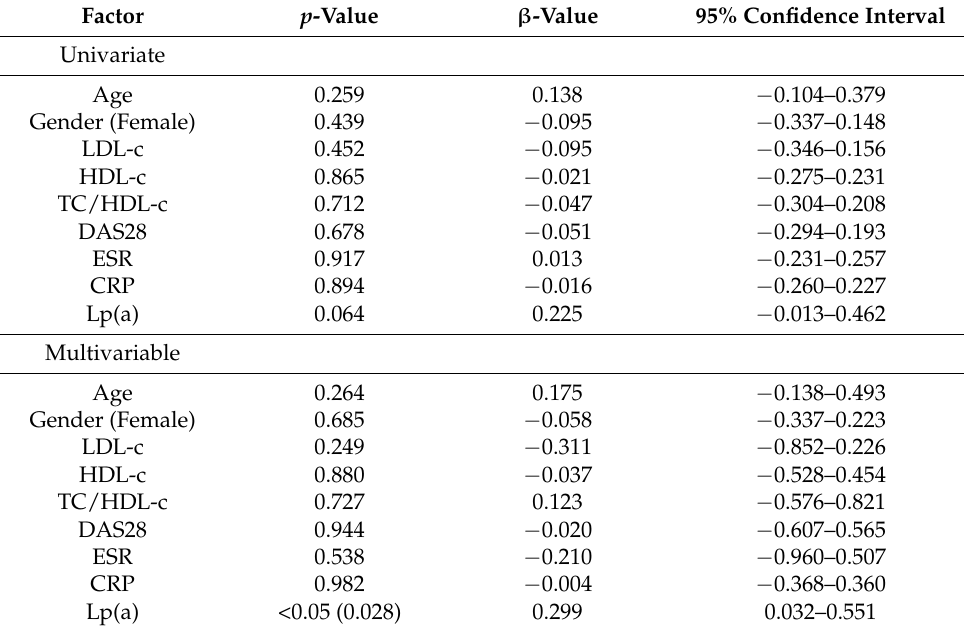
Table 3. Linear regression of baseline levels of lipid profile, RA-related inflammatory parameters, and Lp(a) levels for predicting H5% in 69 patients with